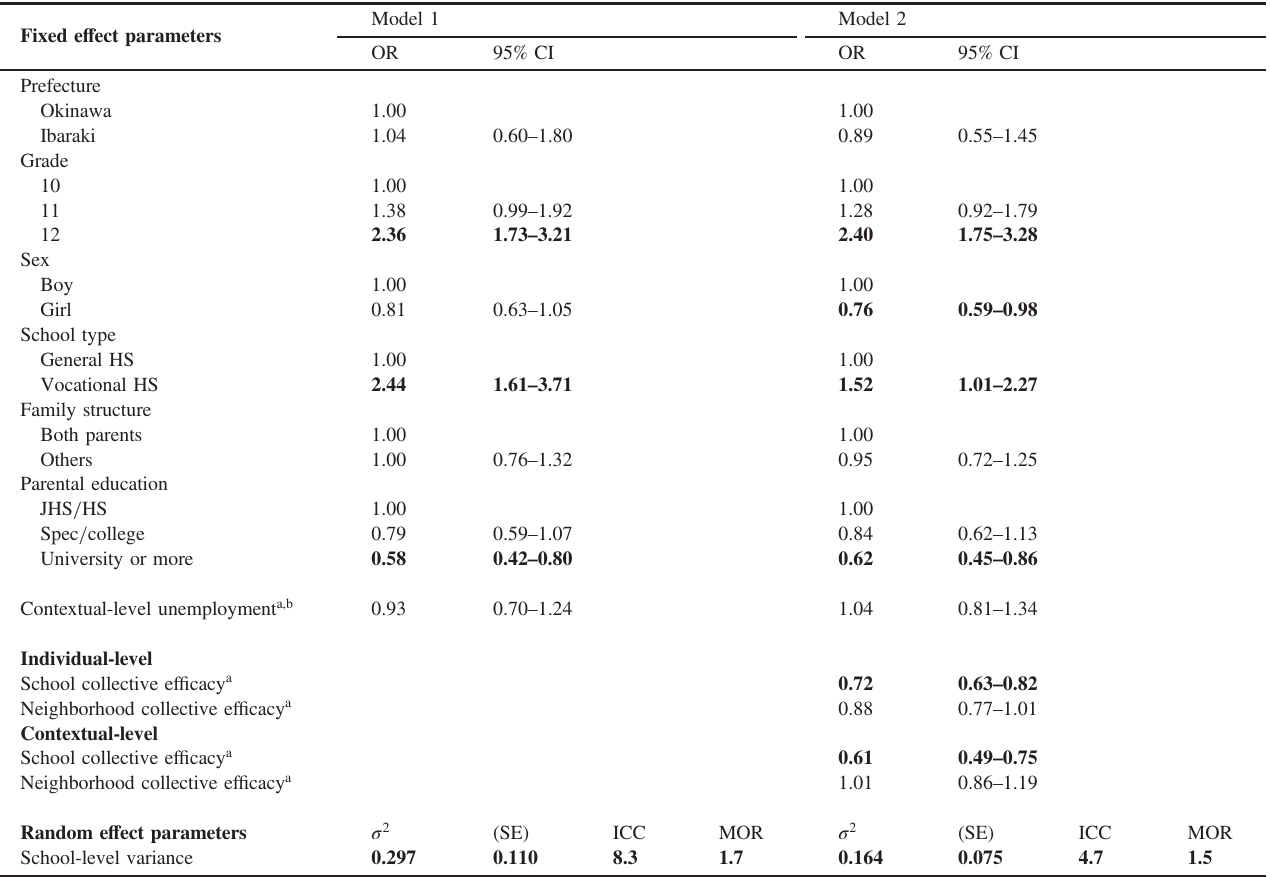
Table 3. Associations of collective e ffi cacy variables and covariates with current alcohol use by the multilevel model ( n = 3,291) Fixed e ff ect